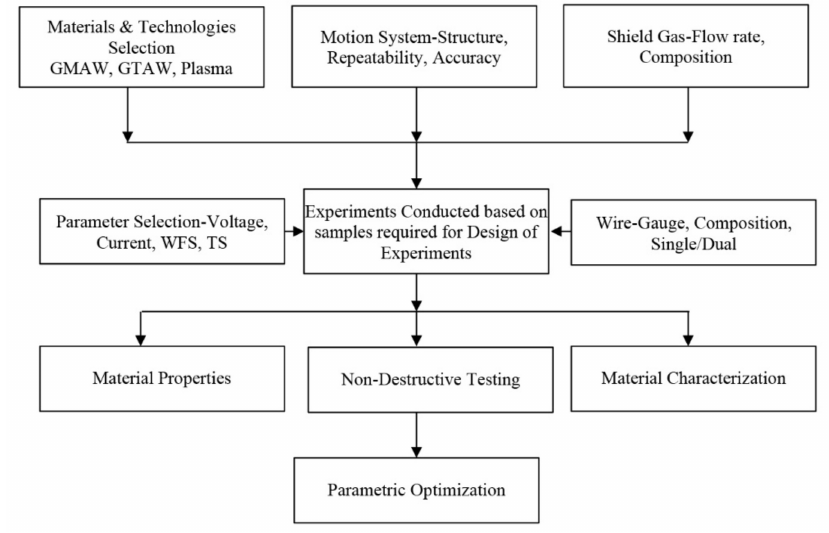
Figure 4. Investigations on WAAM—The